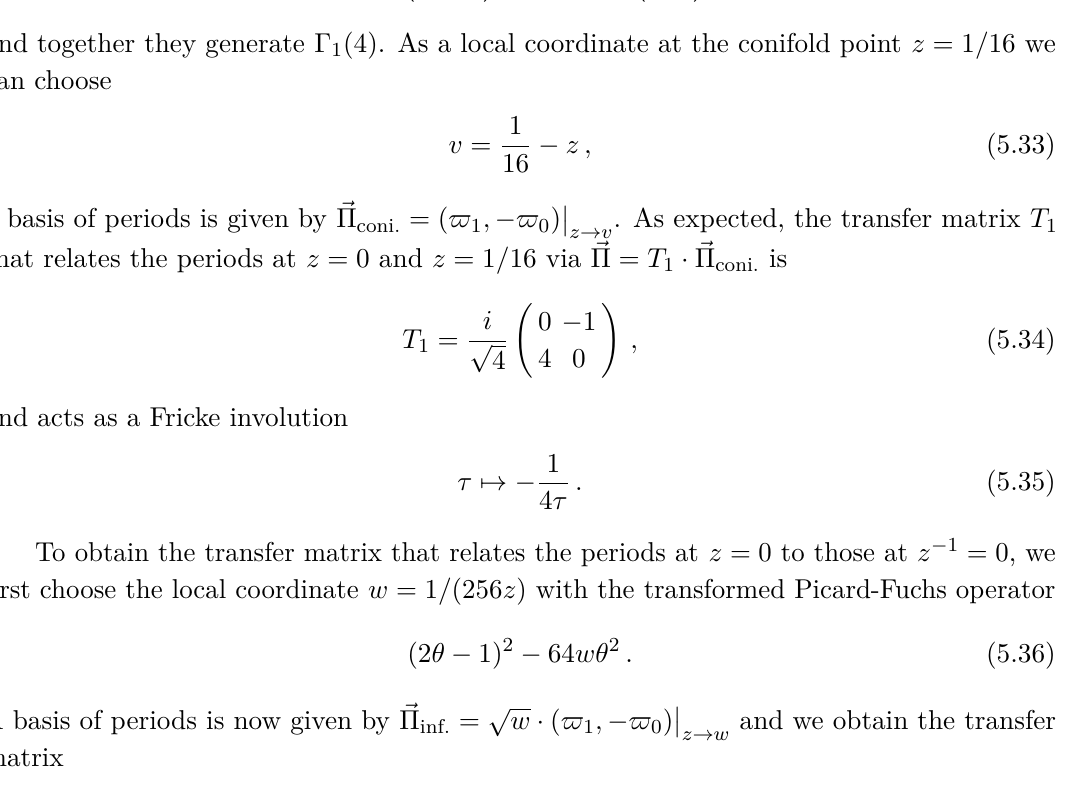
with 4 -sections, the large volume points in 1